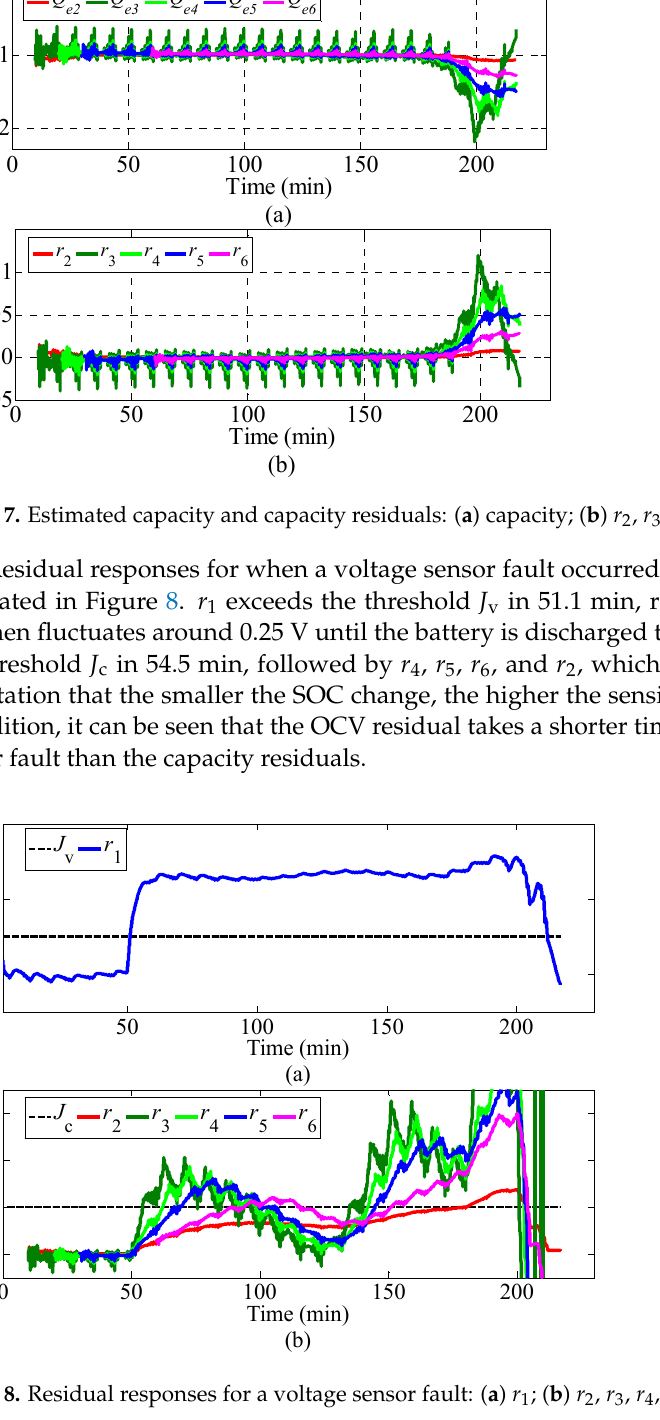
Figure 8. Residual responses for a voltage sensor fault: ( a ) r 1 ; ( b ) r 2 , r 3 , r 4 , r 5 , and r 6 . Residual responses for a current sensor fault occurring at the 50th minute are shown in Figure 9. r 1 increases slowly after the current sensor fault occurs, exceeds the threshold J v at 72.4 min, and continues to increase slowly. Similar to the occurrence of a voltage sensor fault, among the five capacity residuals, r 3 with a relatively smaller SOC change is still the first to exceed the threshold J c at 62.4 min. However, unlike the voltage sensor fault diagnosis, the capacity residuals take a shorter time to detect the current sensor fault than the OCV